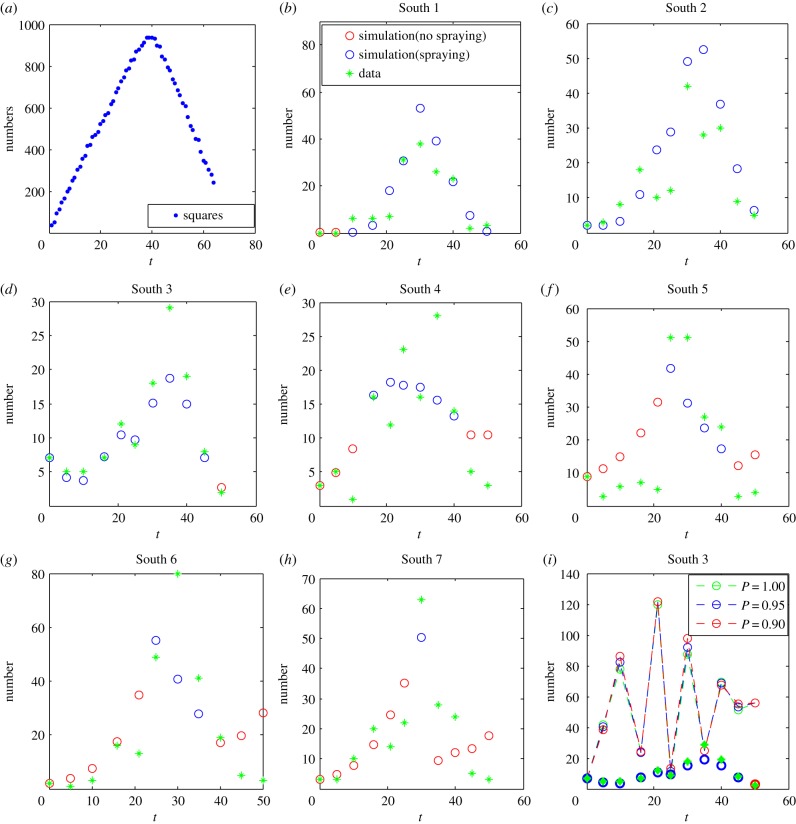
Case study. (a) The function f for determining the growth rate of the pest population during the plant period. (b–h) Results of data fitting for fields South 1–7. (i) Effects of dose–response on the pest population number with parameter values K=125.6677,r¯=0.006,τ=19.874, determined by field South 3. Red circles in (b–h) represent points when the pesticide was not applied. (Online version in colour.)